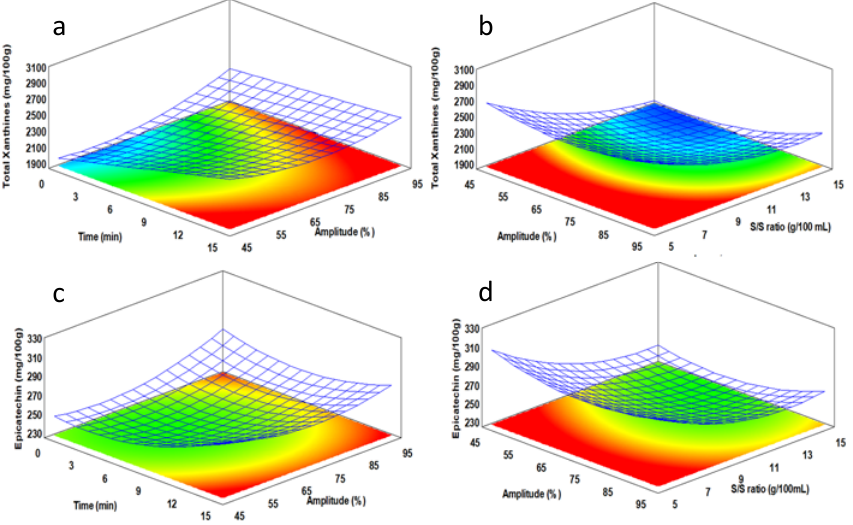
Figure 3. 3D response surface plots. Combined effects of the high-intensity ultrasound extraction conditions, on the recovery of ( a , b ) total xanthines (caffeine + theobromine); and ( c,d ) epicatechin. The application of regression equations allowed analysis of extraction conditions.